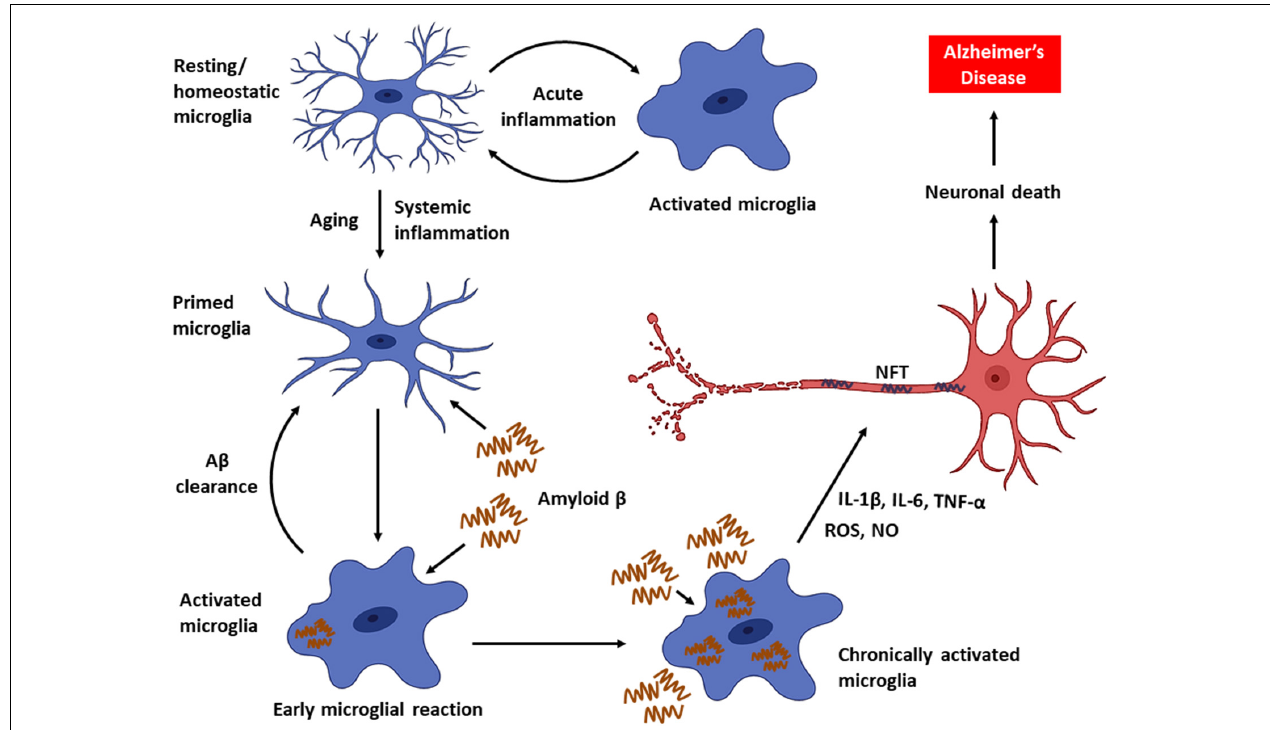
FIGURE 1 | Microglial activity in health and disease. Microglia, the primary innate immune cells in the CNS elicit a protective immune response during an acute brain injury. Microglia are primed with aging. Chronic activation of microglia by A β triggers the persistent release of proinflammatory mediators, which can eventually cause neuronal death leading to